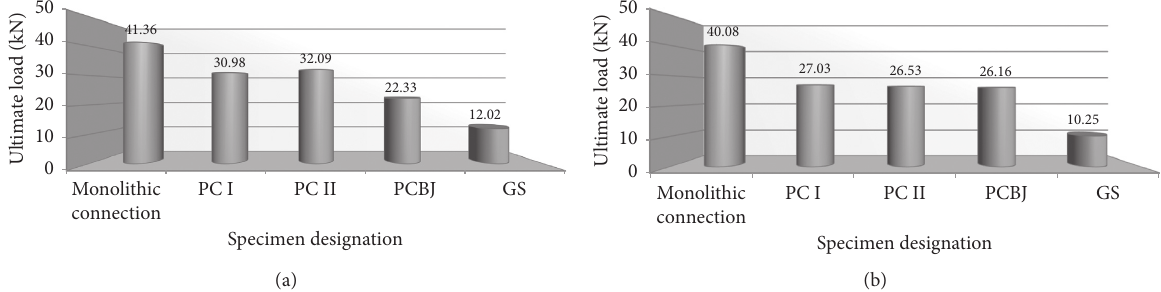
Figure 12: (a) Ultimate load of all specimen in the positive direction; (b) ultimate load of all specimen in the negative direction.